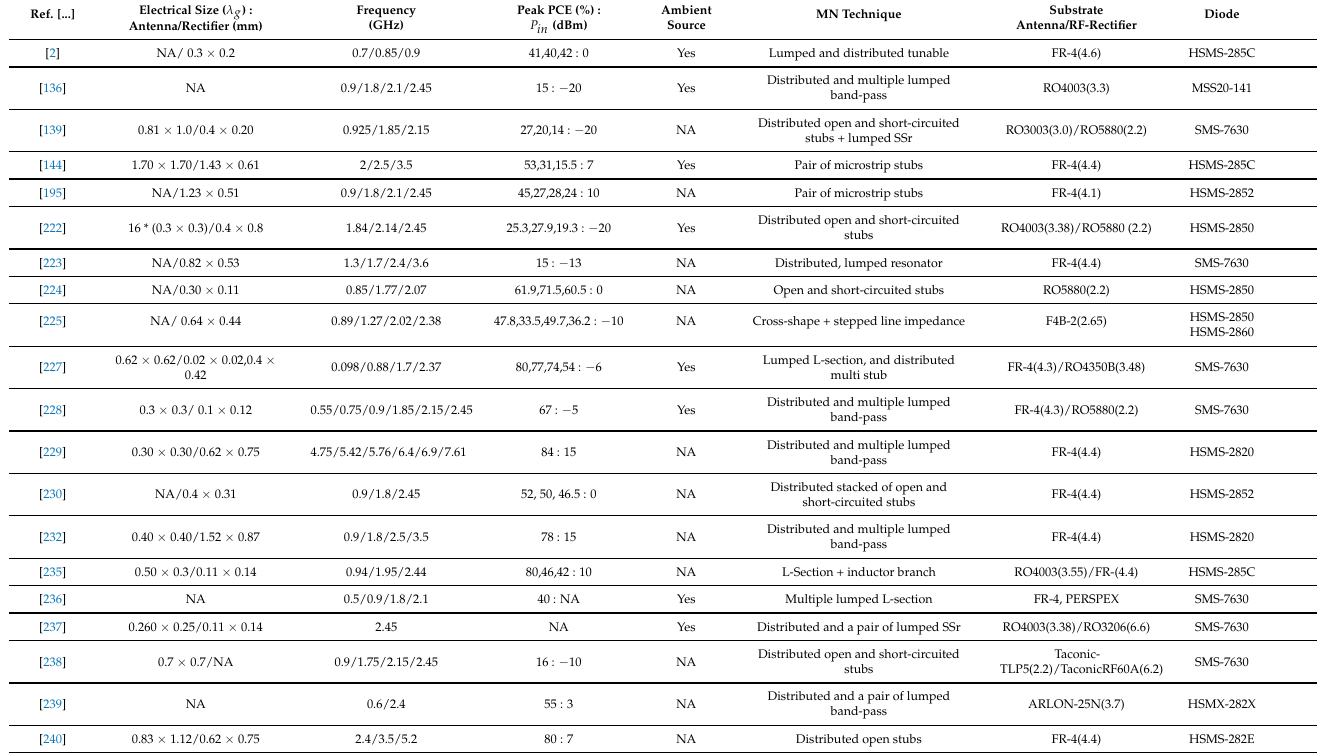
Table 4. Comparison of some basic multi-band RFEH